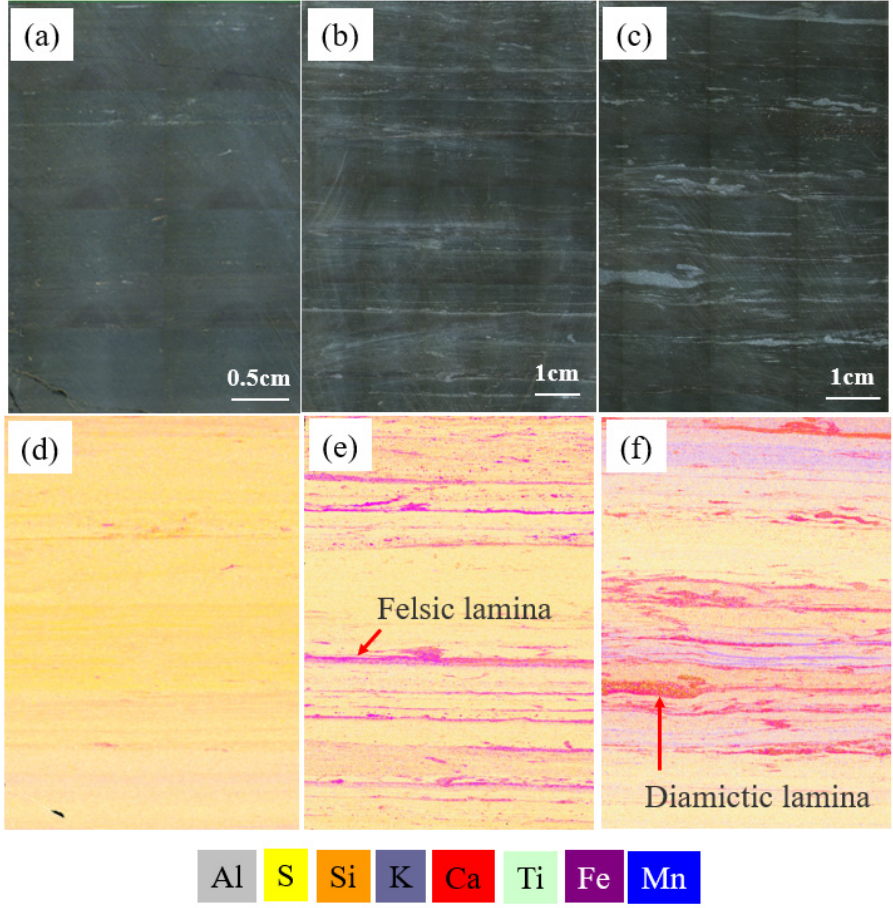
Figure 4. Results of core observation and XRF analysis: ( a ) photo of foliaceous shale; ( b ) photo of laminated feisic shale; ( c ) photo of laminated diamictic shale; ( d ) element distribution of foliaceous shale; ( e ) element distribution of laminated feisic shale and ( f ) element distribution of laminated diamictic shale.